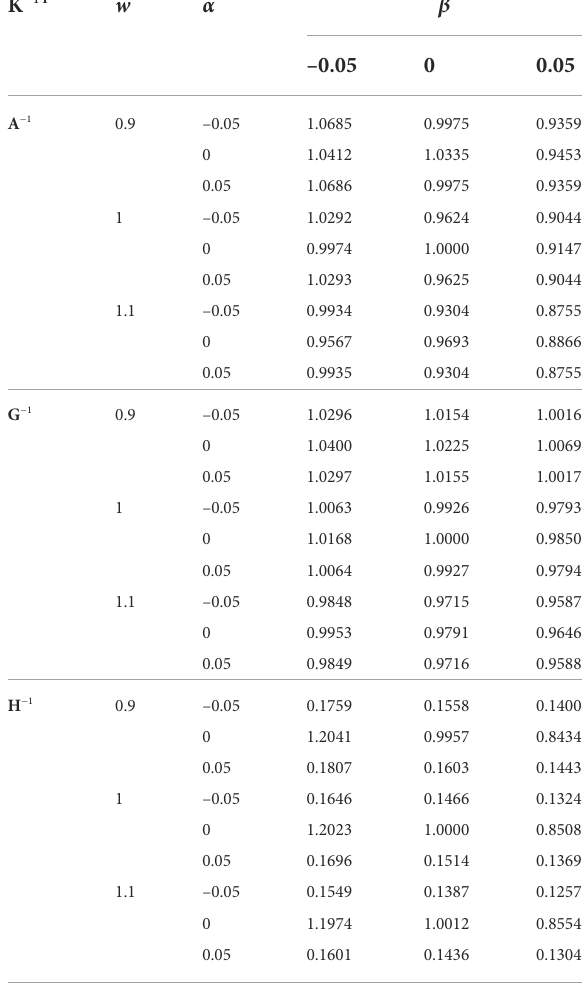
TABLE 6 The effect of w , α , and β ( w K − 1 + α 11 ′ + β I) on the regression coef fi cient of predicted breeding values on those using the originalK − 1 ( w =1, α =0,and β =0).Thesameheritability(basedonthe original K − 1 ) was used in all the